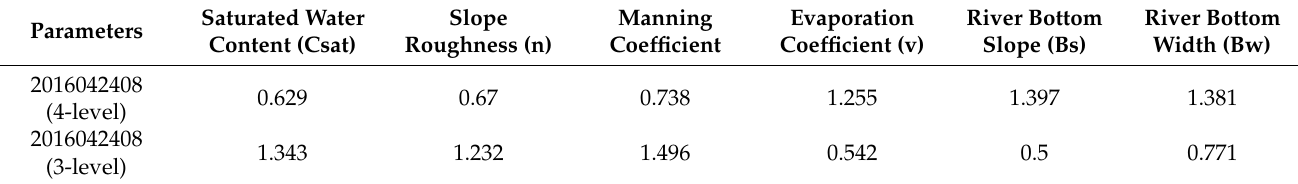
Table 6. Parameter results of the three- and four-level channel